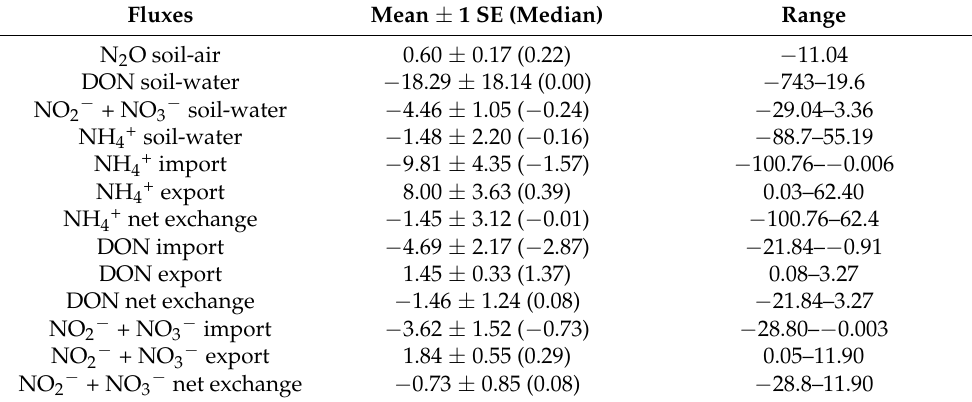
Table 2. Estimates of net NO and N 2 O gas and dissolved nitrogen fluxes (mg N m − 2 d − 1 ) across the mangrove soil surface and rates of DON and DIN exchange between mangrove forests and adjacent tidal waterways, including mangrove-fringed estuaries. Negative rates indicate fluxes into the soil and DN exchanges importing into the mangroves. Positive values indicate fluxes from the soil to either the overlying water or atmosphere and the exporting of DN to adjacent tidal waters.